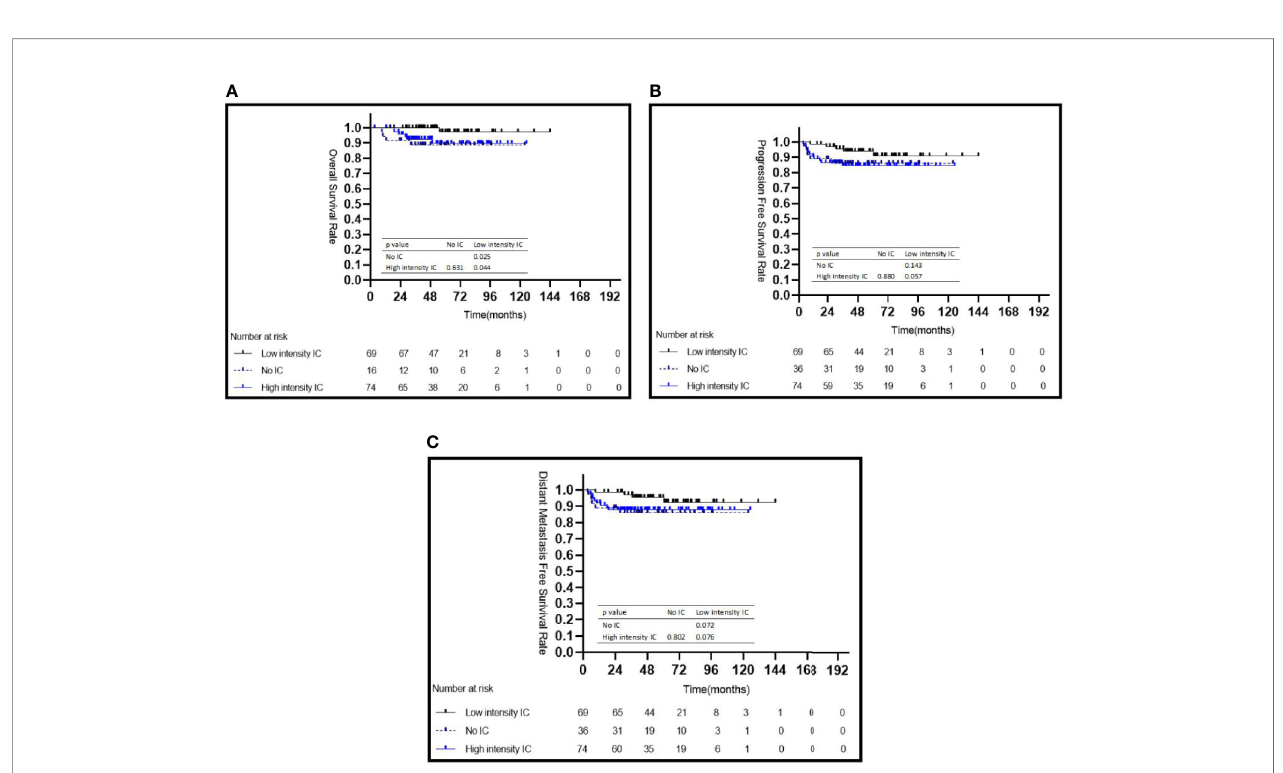
FIGURE 2 | Kaplan – Meier survival curves for 179 patients with NPC strati fi ed by intensity of induction chemotherapy (A – C) . IC, induction